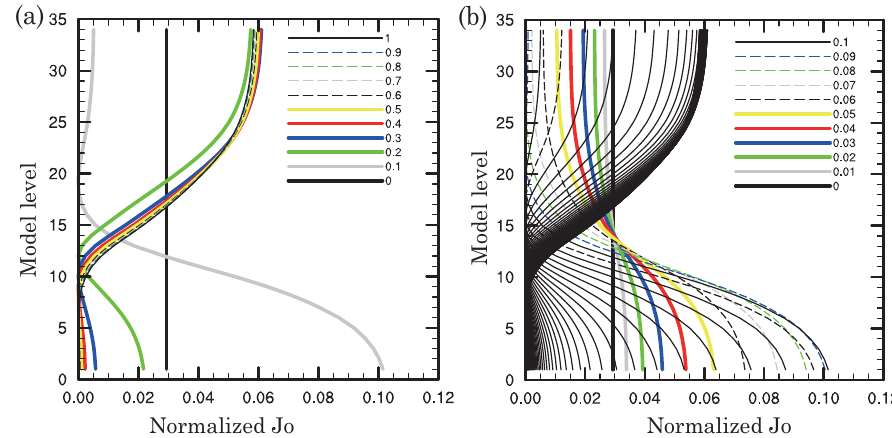
Figure 3. The normalized J o (a) at the interval of 10% and (b) at the interval of 1%. In (b) , the normalized J o from 0.1 to 1 are all denoted as black